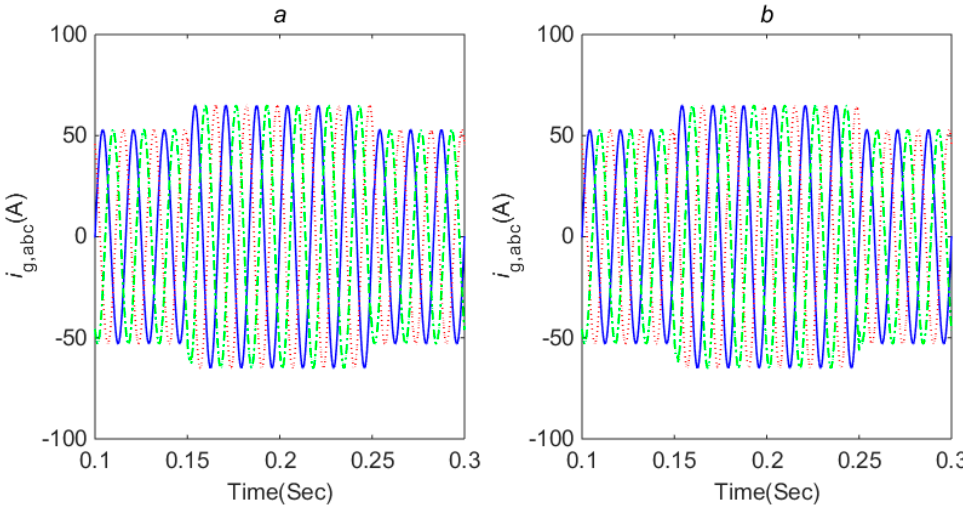
Figure 4. Master distributed generation unit (DGu) output current ( a is under RHOSM and b is under AHOSM).